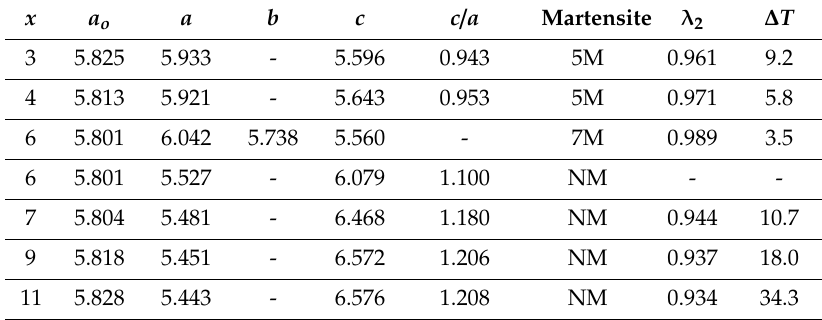
Figure 6. Thermal hysteresis versus middle eigenvalue of the transformation stretch matrix (λ 2 ).